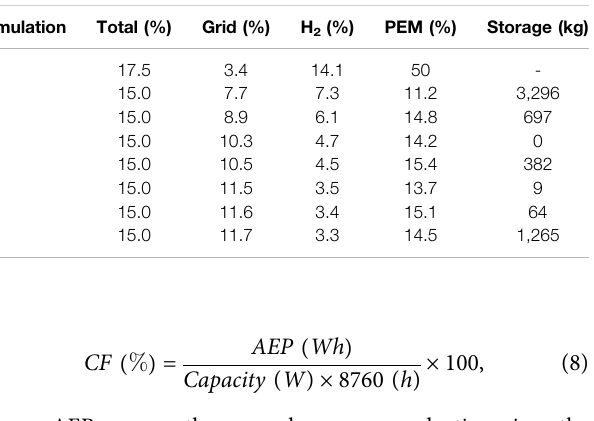
TABLE 3 | The summary of capacity factor, PEM usage rate and H 2 storage resulted from the all simulations. Total, Grid and H 2 indicate that the electricity generated by PV plants, transmitted into the grid (load) and electrolysis,